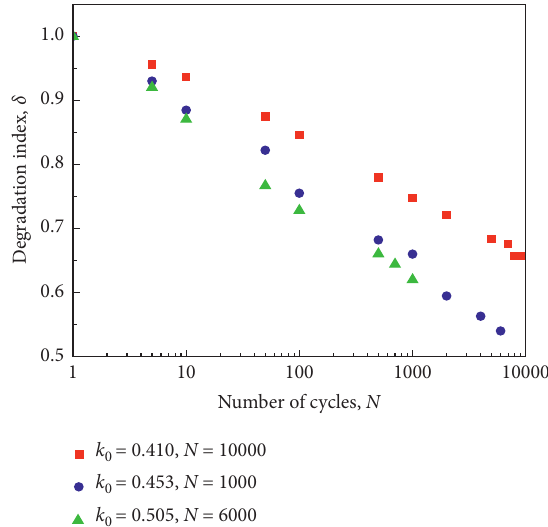
Figure 7: Development of the degradation index when the deviatoric consolidation ratio ( K 0 ) is 0.410, 0.453, and 0.505.